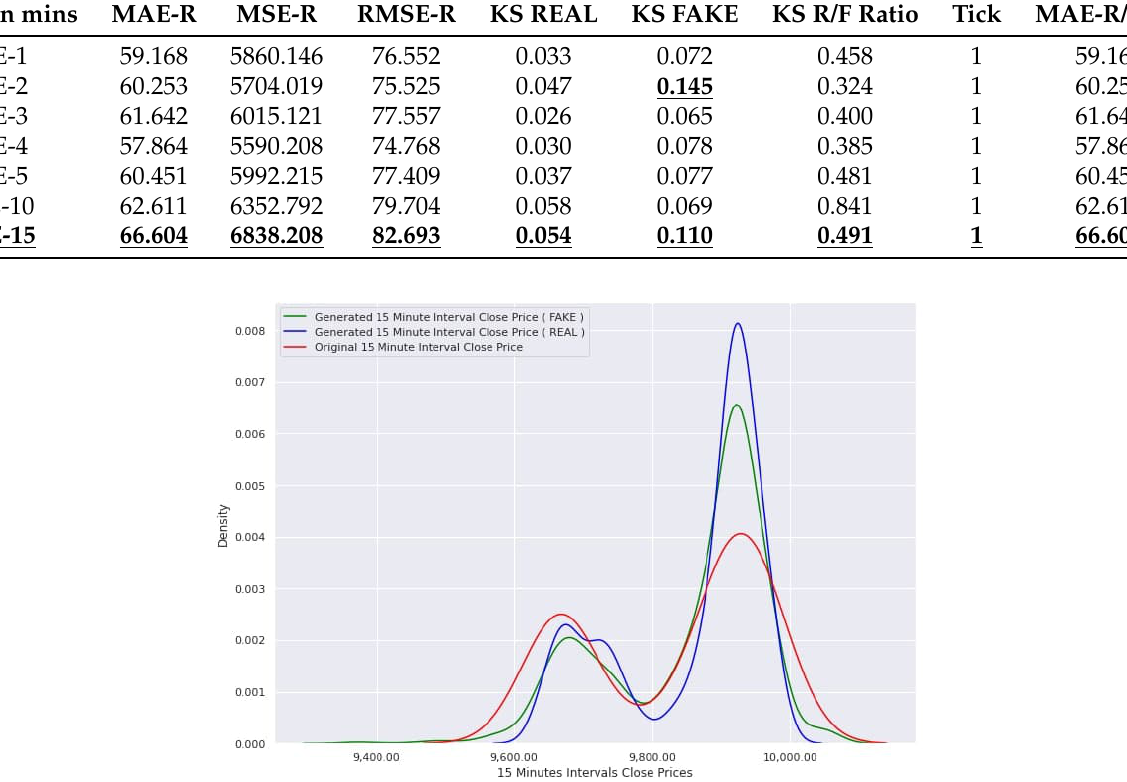
Figure 6. Platinum futures contract (PLE) 15 minutes interval has a larger MAE-R 140.385 than other contracts. Price is concentrated in a certain range and generated long-tailed prices can represent more abundant prices than the original